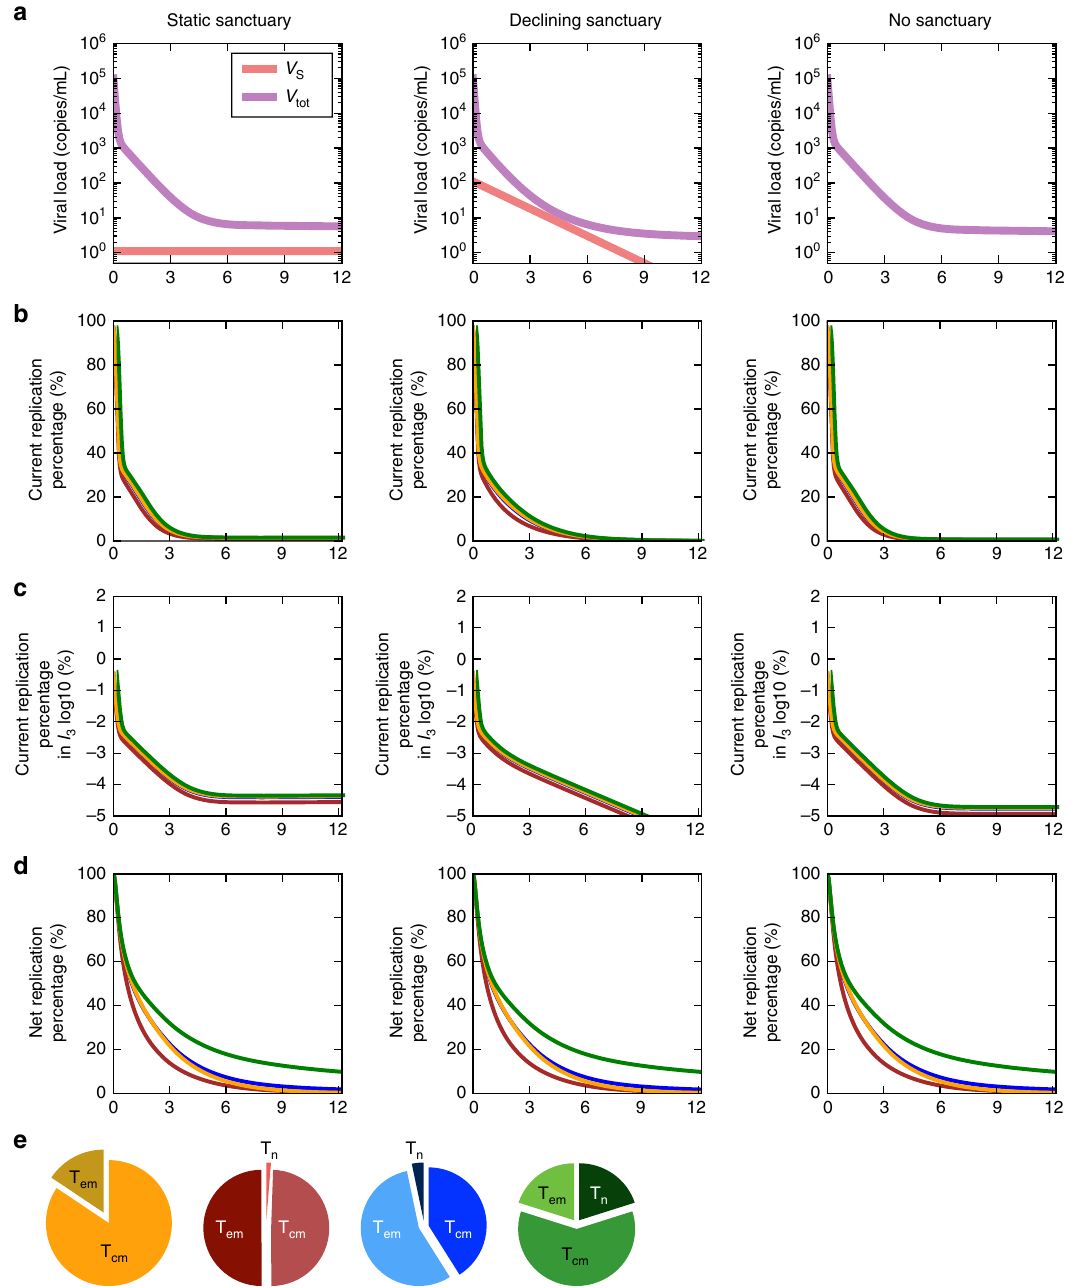
Fig. 7 Most infected cells are generated via proliferation within 6 months of ART initiation. Model simulations contrast the number of cells generated by viral replication with those generated by cellular proliferation. The fraction of cells that arose due to viral replication at a time point is referred to as the current replication percentage. The fraction of cells remaining that arose at any time due to viral replication is referred to as the net replication percentage. Simulations are identical except for different assumptions regarding a drug sanctuary ( I S ) in each column. a Moving left to right, we assume a static drug sanctuary, a slowly declining drug sanctuary and no drug sanctuary. b Under all assumptions, once ART is initiated, most current infected cells arise due to cellular proliferation as opposed to HIV replication after 12 months of ART. c Current latently infected reservoir cells ( I 3 ) are generated almost entirely by proliferation soon after ART is initiated under all conditions. d The fraction of cells that remain that were generated by replication at any time (net) overestimates the fraction generated current percentage during the fi rst 6 months of ART — a trend that is more notable when the reservoir contains a higher proportion of slowly proliferating naive T cells. Importantly, this is the quantity that would be observed experimentally (see Fig. 8). e Pie charts indicate reservoir compositions of T cell subsets from published data and correspond with colored lines in a –